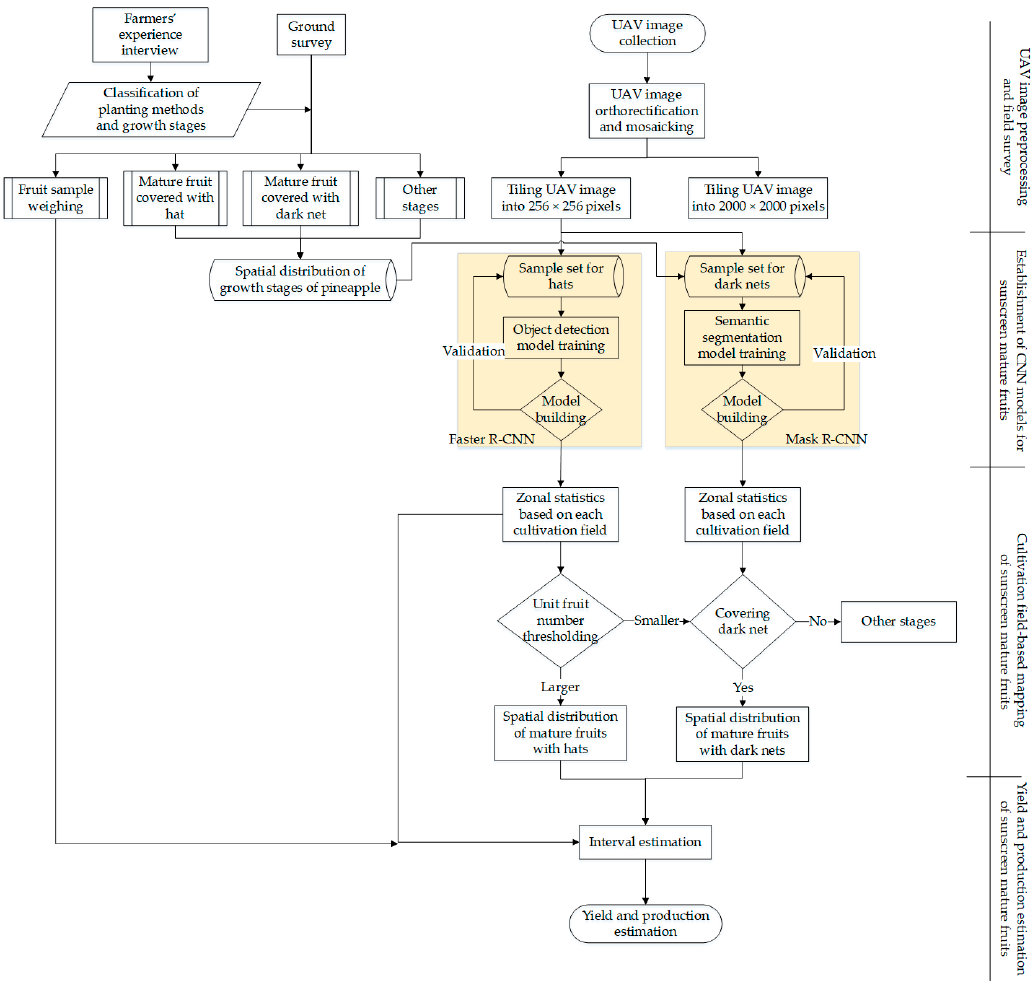
Figure 6. Flowchart of this